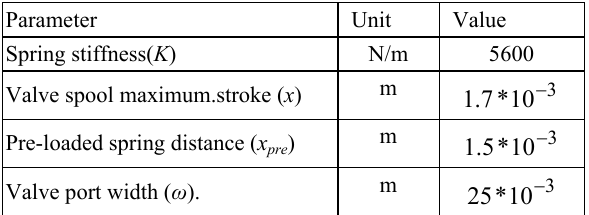
Table 1. Spring and hydraulic forces parameters identification